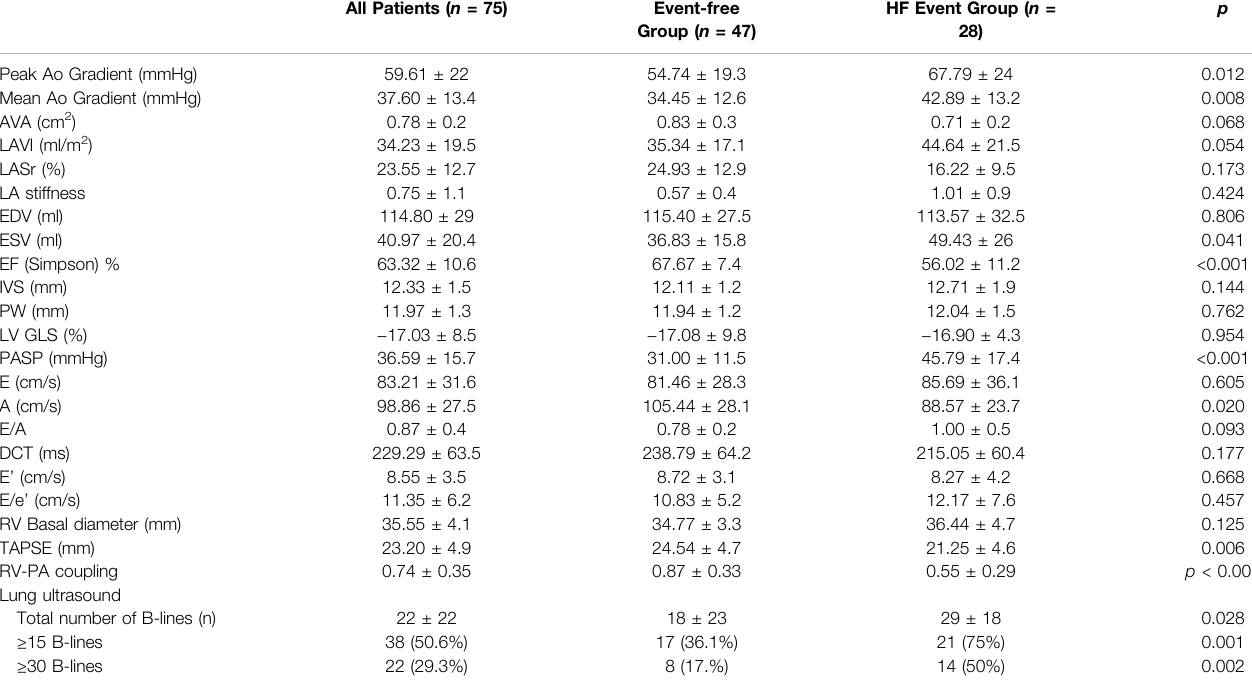
TABLE 2 | Baseline echocardiographic characteristics of the study population and comparisons between patients with and without events. All Patients ( n =